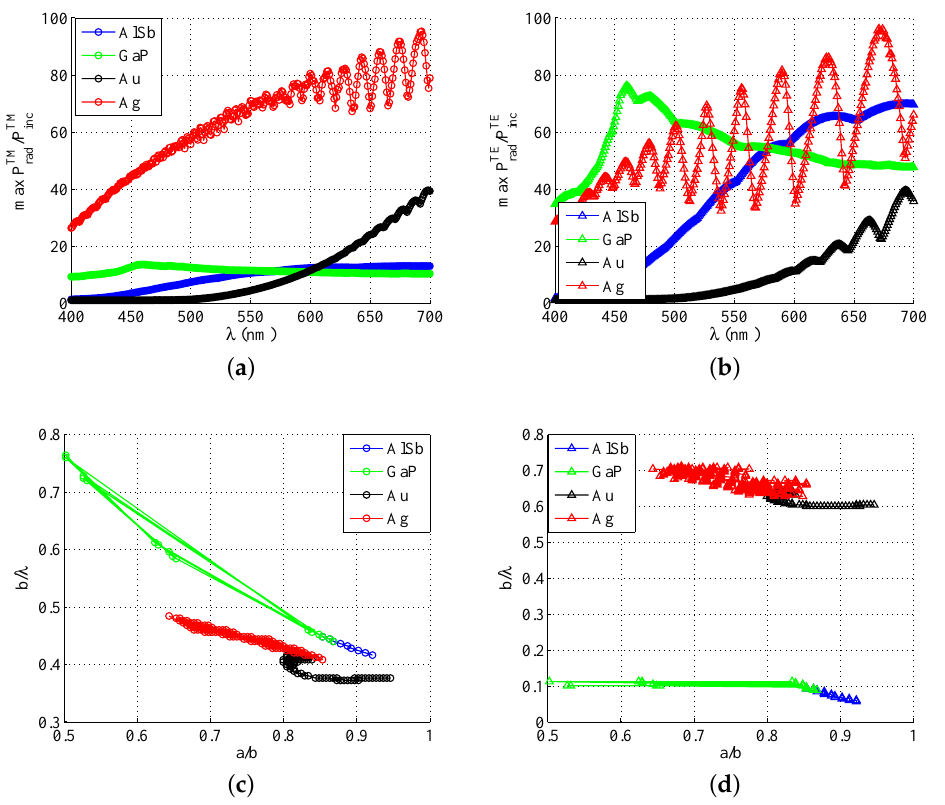
Figure 3. ( a , b ) Maximum relative radiation as function of operational wavelength λ with use of covers made of several materials for: ( a ) TM excitation and ( b ) TE excitation; ( c , d ) trajectories of optimal designs on the ( a / b , b / λ ) plane as the wavelength λ changes for: ( c ) TM excitation of the systems of ( a ) and ( c ) TE excitation of the systems of ( b